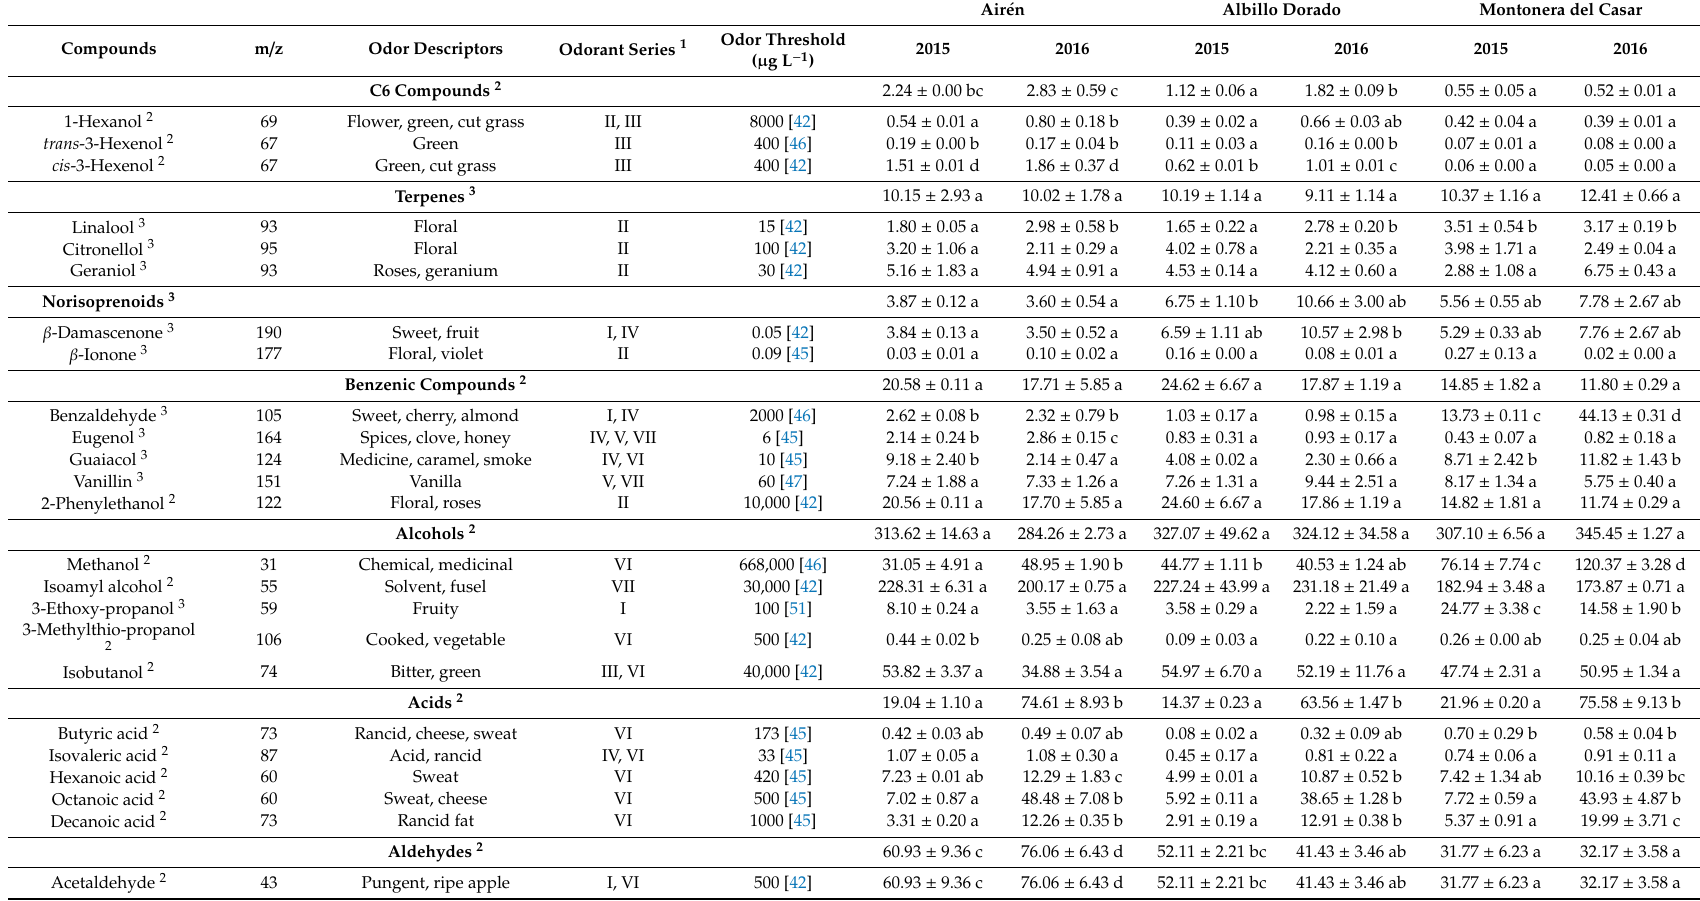
Table 2. Aroma volatile composition (mean value ± standard deviation, n = 2) in white wines made from Air é n and the novel grape genotypes. Air é n Albillo Dorado Montonera del